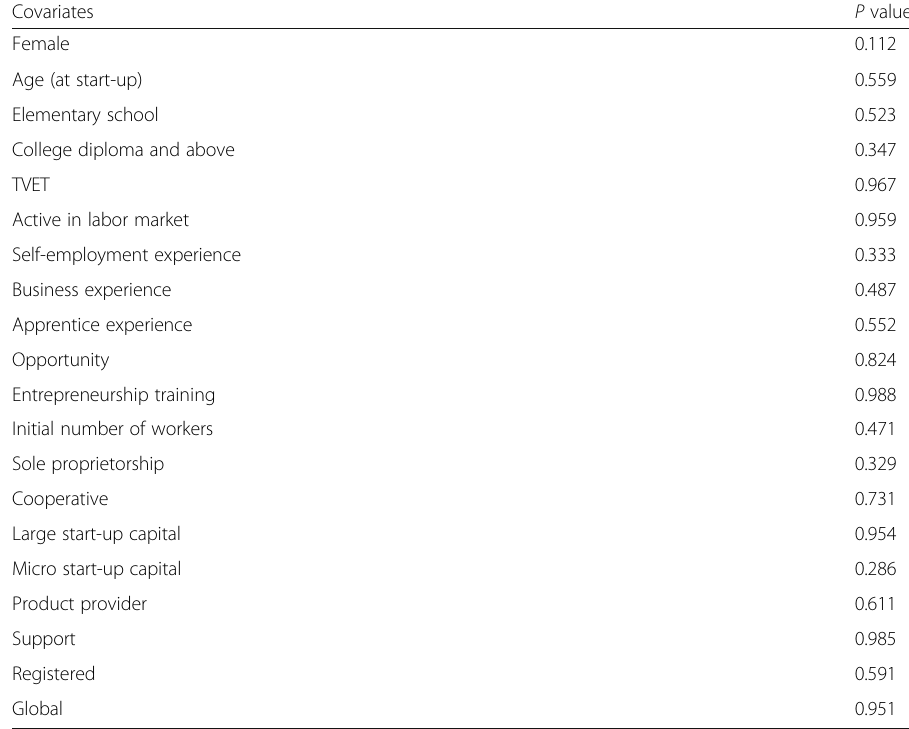
Table 5 Proportional hazard test using chi-square statistics: Cox model analysis — model